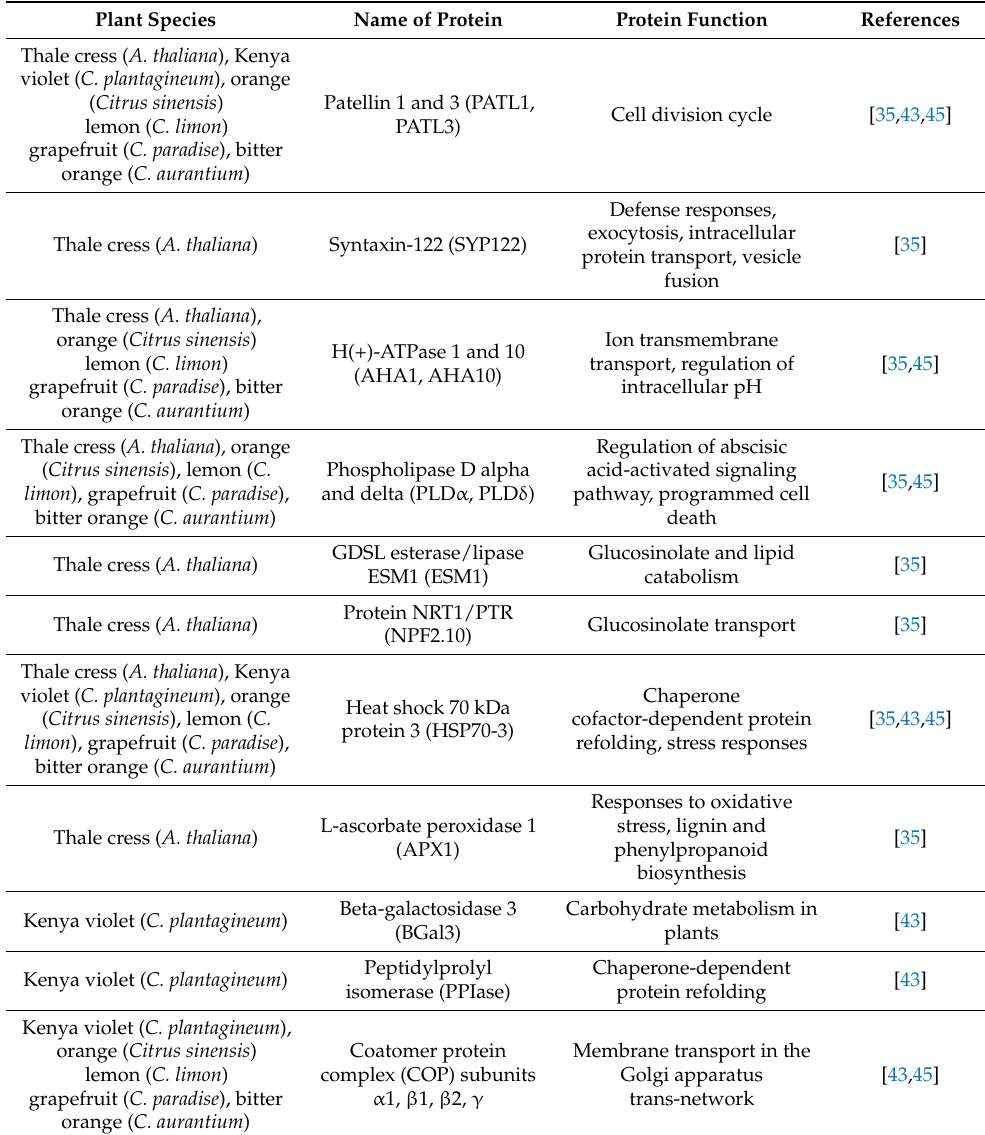
Table 1. Cont . Plant Species Name of Protein Protein